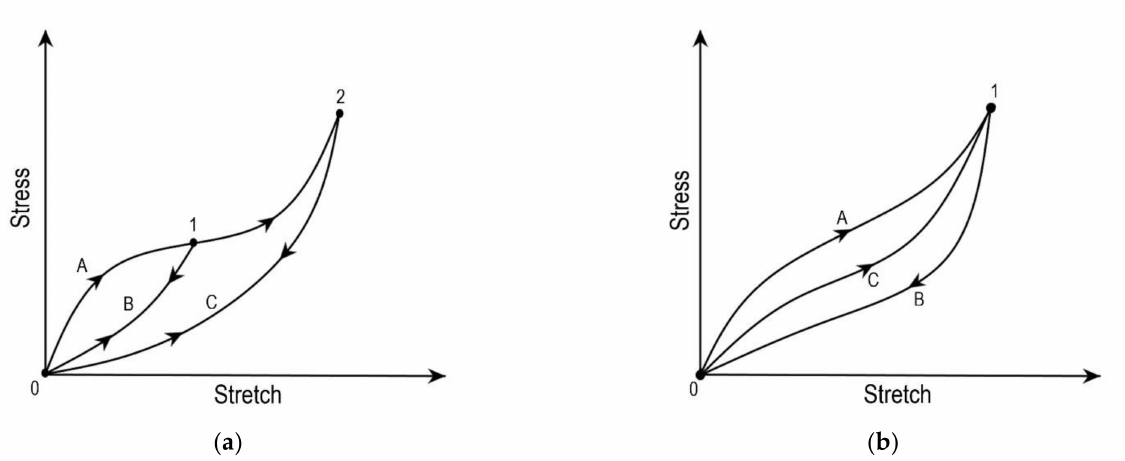
Figure 4. Stress vs. stretch plots describing ( a ) Idealized response of the Mullins effect where path A–B first cycle and second cycle path A–C affected by softening, ( b ) Stress softening in hysteresis, A-B first cycle and C–B second cycle affected by